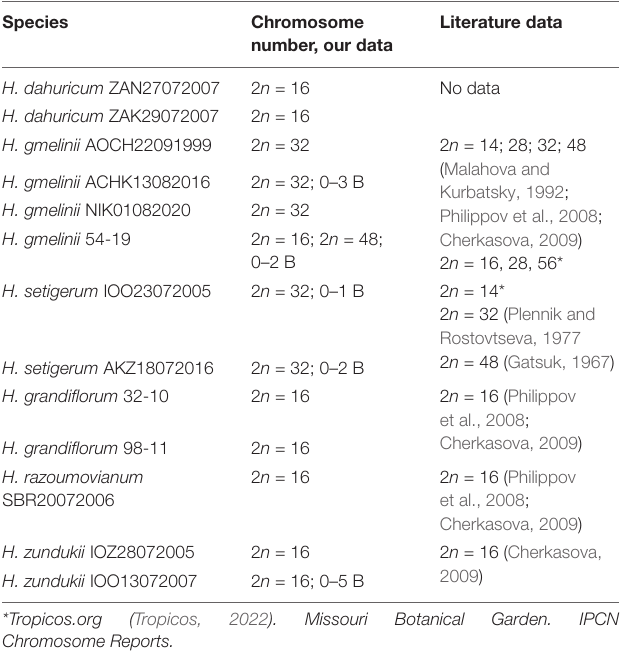
TABLE 3 | Chromosome numbers determined in the studied Hedysarum species.